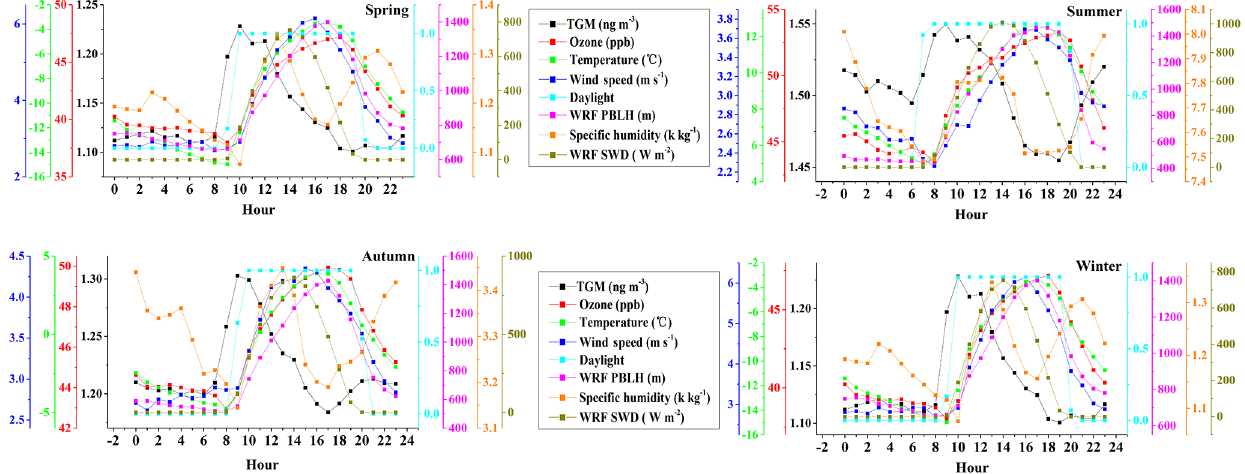
Figure 8. Diurnal profiles of TGM, ozone and meteorological parameters (temperature, wind speed, daylight, WRF PBLH (planetary bound- ary layer height), specific humidity and WRF SWD (downward shortwave radiation)) at Nam Co Station by season for the measurement